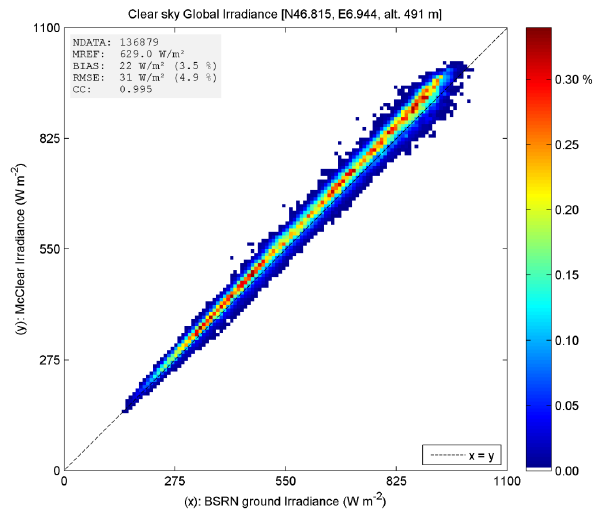
Fig. 6. Scatter density plot between BSRN 1min clear-sky data and McClear. Payerne. Global clearness index KT.